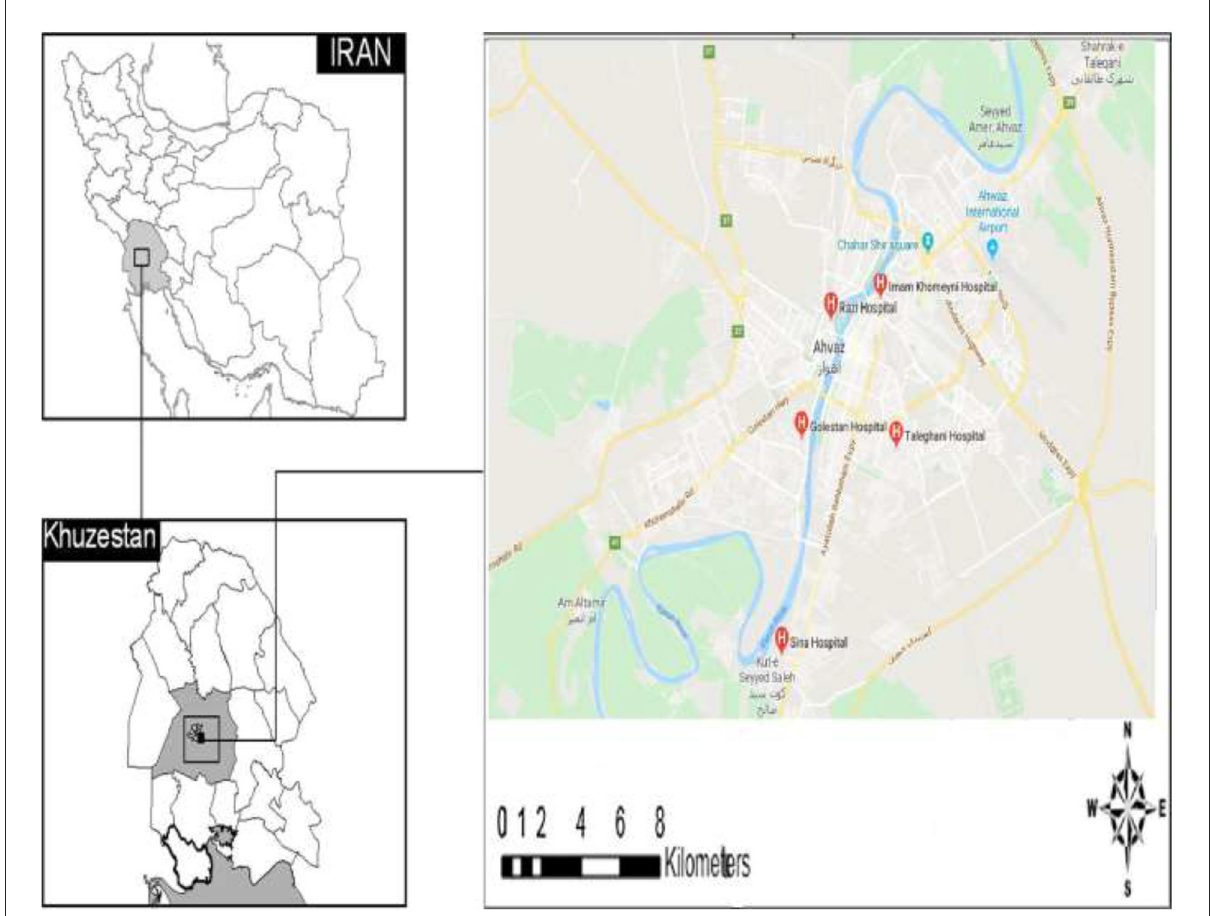
FIGURE1 Location of the study area educational hospital affiliated to Ahvaz Jundishapur University of medical sciences, in the south west of Ahvaz, Iran.